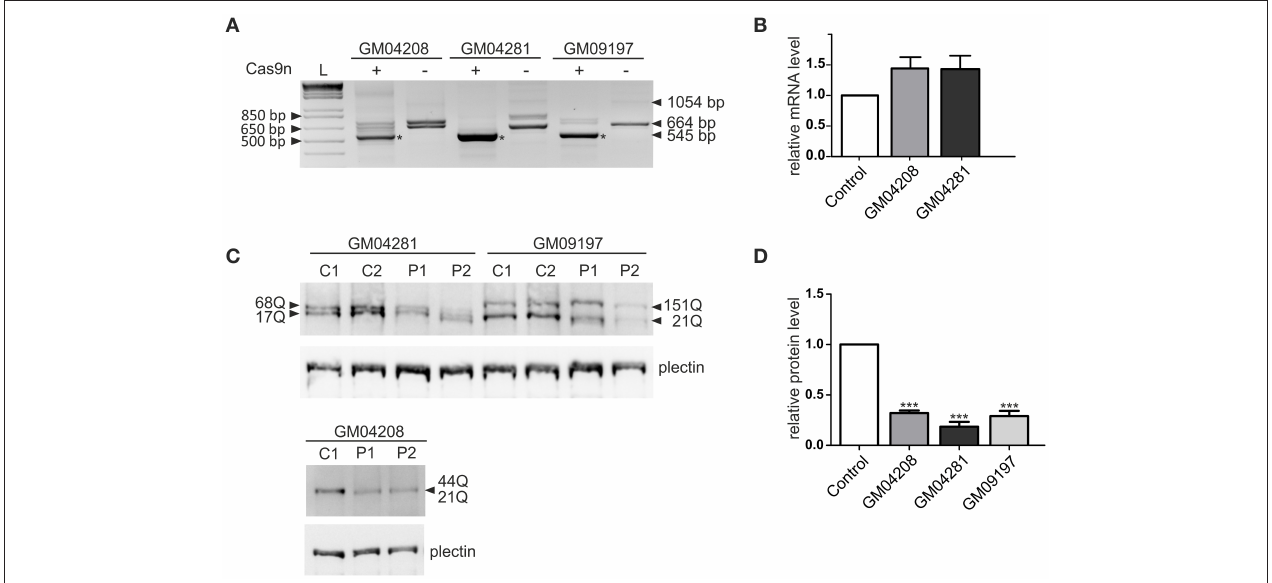
FIGURE 3 | Huntingtin inactivation via the Cas9 nickase pair in patient-derived fibroblasts. (A) RT-PCR analysis of the Cas9n/HTT_sgRNA1 + 4 - edited ( + ) and non-edited (–) HTT gene product in the three human HD cell lines containing 21/44 (GM04208), 17/68 (GM04281) and 21/151 (GM09197) CAG repeats. As a result of repeat excision, shorter PCR products ( ∼ 545 bp, marked with an asterisk) are present. (B) RT-qPCR analysis of the HTT mRNA levels in the human fibroblast cell lines transfected with the Cas9n/HTT_sgRNA1 and sgRNA4 plasmid pairs. All samples are normalized to human GAPDH, and the results are the mean ( ± SEM) relative to the cells transfected with the control Cas9n plasmid (one-way ANOVA followed by Bonferroni’s post hoc test; the difference was non-significant). (C) Representative western blots showing the HTT protein levels in the control fibroblasts treated with the empty Cas9n plasmids, expressing only Cas9 protein and not sgRNA (C1 and C2) and in the Cas9n/HTT_sgRNA1 + 4-treated cells (P1 and P2). Plectin was used as the loading control. The lengths of the polyQ tracts in both alleles of the HTT protein in each cell line are marked with an arrow. (D) The quantification of the huntingtin levels in the three human HD cell lines transfected with